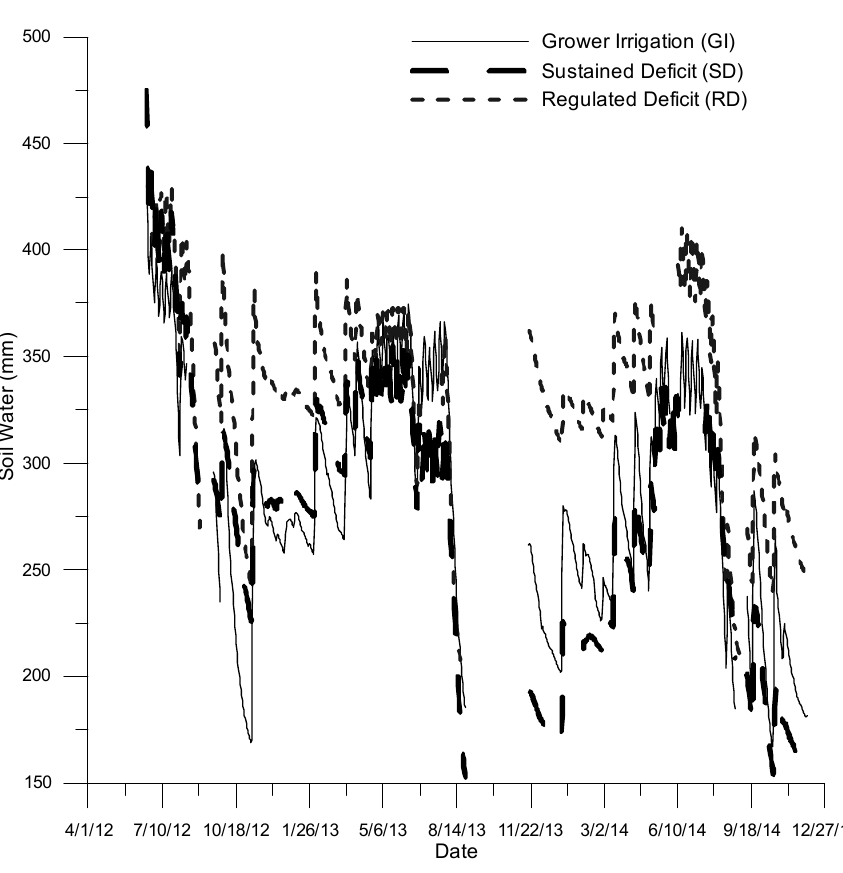
Figure 2. Soil water (mm) in 1.5 m of soil profile measured with capacitance probe. One measurement site in each treatment.